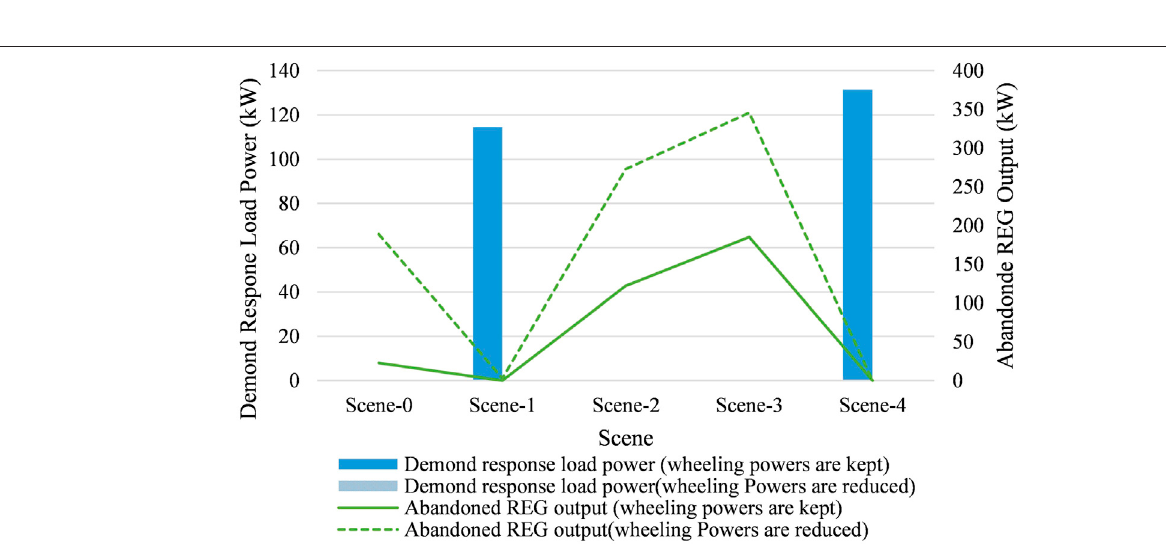
Frontiers in Energy Research |